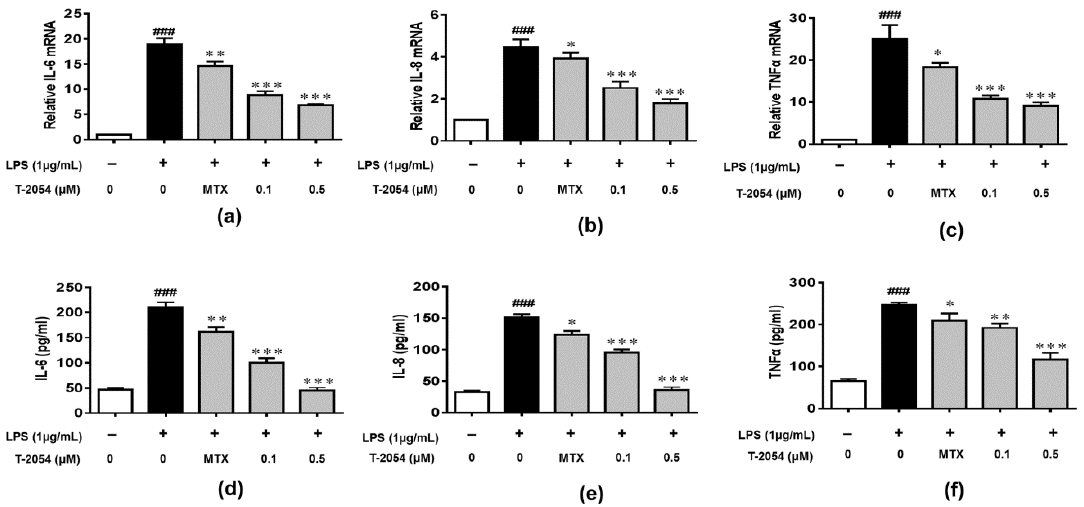
Figure 3. Gene and protein expression of IL-6, IL-8 and TNF-α. The RAW 264.7 cells were treated with LPS (1 μg/mL) 1 h later, T-2054 was added for 6 h. The total RNA was collected, and mRNA levels of IL-6 ( a ), IL-8 ( b ) and TNF-α ( c ) were analyzed by qPCR. The RAW 264.7 cells were exposed to LPS (1 μg/mL) for 1 h before T-2054 was added. After 16 h, supernatants were collected, and levels of IL-6 ( d ), IL-8 ( e ) and TNF-α ( f ) were analyzed by ELISA. Actin was used as an internal control to normalize the data. Each value represents the mean ± SD, performed in 3 different experiments. ### p < 0.001 vs. CON group; * p < 0.05; ** p < 0.01; *** p < 0.001 vs. LPS group.